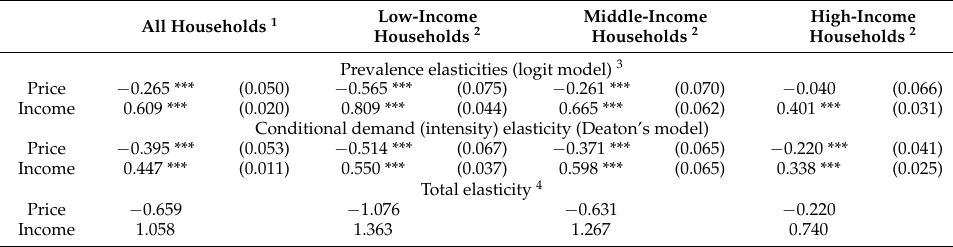
Table 2. Prevalence and conditional demand elasticities by income